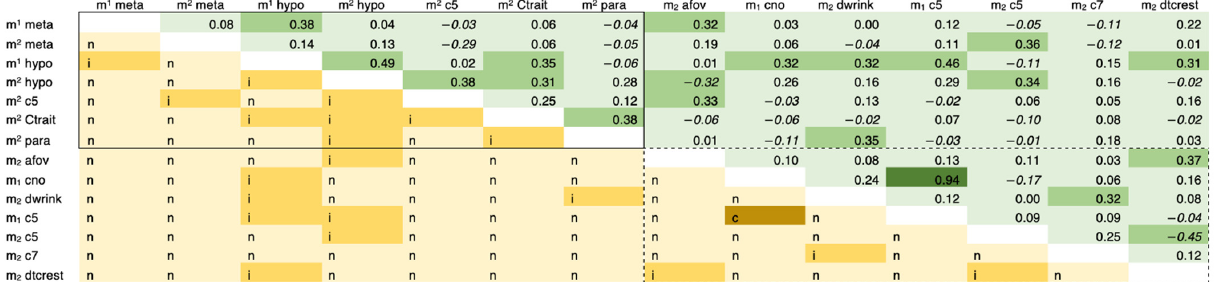
Figure 1. Genetic correlation matrix for deciduous molar morphology. Correlation estimates are shown above the diagonal with positive values nonitalicized and negative values italicized. Cells are shaded based on absolute estimate values (<0.3 = light green; 0.3-0.6 = green; >0.6 = dark green). Pleiotropy-based model likelihood results are shown below the diagonal (n = no pleiotropy; i = in- complete pleiotropy; c = complete pleiotropy). Cells are shaded based on degree of pleiotropy (n = light yellow; i = yellow; c = dark yellow). Model results for within-arcade trait pairs are enclosed in boxes. Maxillary trait pairs are outlined with a solid line and mandibular trait pairs are outlined with a dotted line. For trait names and abbreviations, see Table 1.